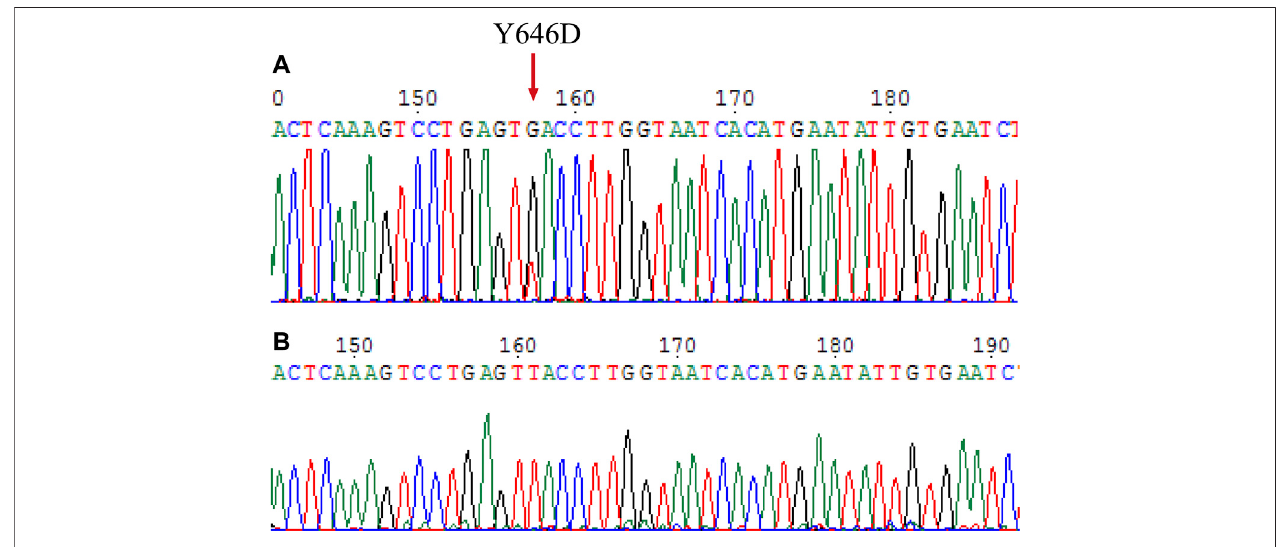
FIGURE 3 | Mutation analysis on the c-KIT gene for surgical melanoma specimen. (A) Tumor FFPE tissue. (B) Normal marginal